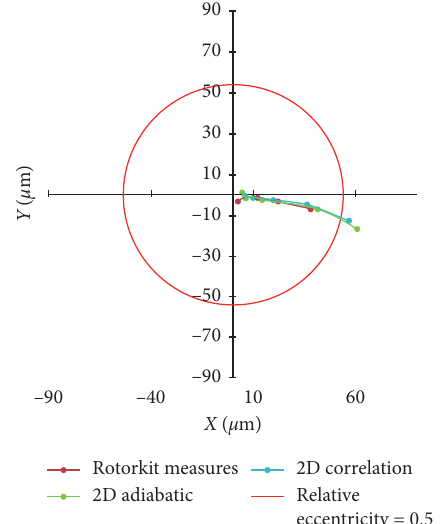
Figure 11: Journal center locations for the modified RK in con- figuration 2.